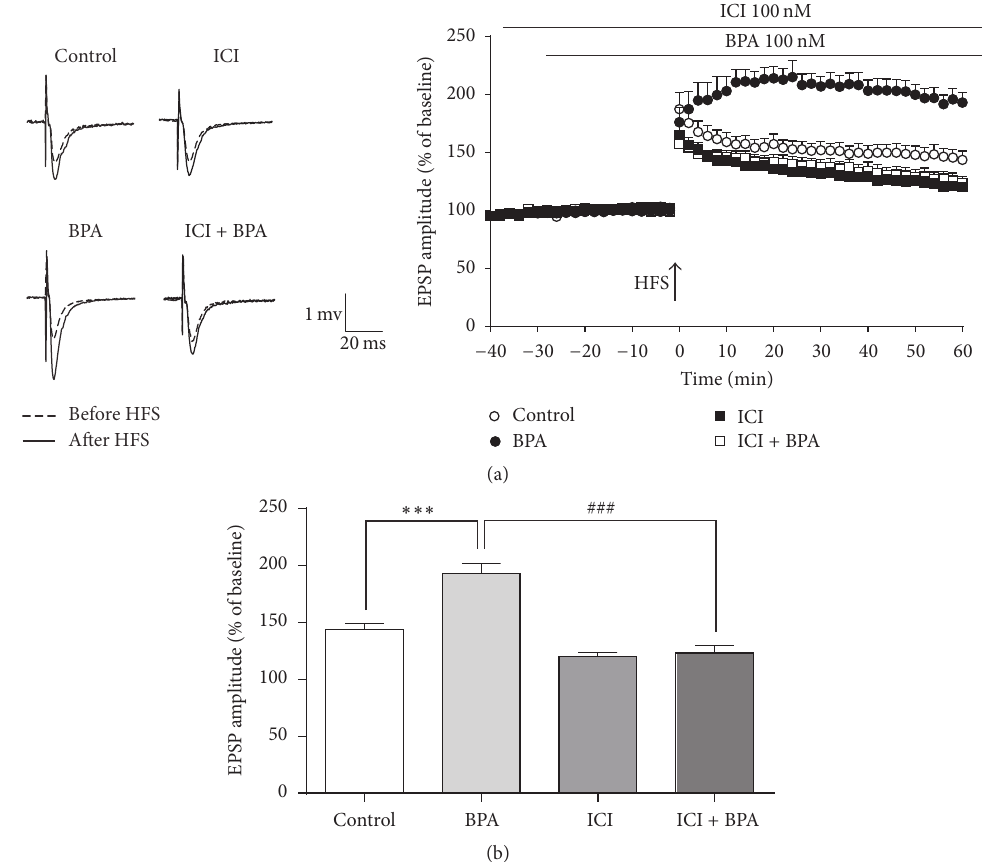
Figure 2: The enhancement of BPA on hippocampal LTP was ER-dependent. (a) Administration of ICI 182,780 10nM (an antagonist of ERs, filled square, 𝑛 = 8 ) remarkably decreased the 100 nMBPA-induced enhancement of LTP. Pretreatment with the ERs antagonist ICI 182,780 30 min before BPA 100 nM (open squares, 𝑛 = 8 ) application completely blocked BPA-enhanced LTP compared with BPA alone. (b) Figure columns express the average fEPSP amplitudes after HFS in separate perfusion or coperfusion of BPA 100 nM and ICI 182,780 100nM, ∗∗∗ 𝑝 < 0.001 as compared to the control, ### 𝑝 < 0.001 as compared to the BPA 100 nM. Solid and dashed example traces before HFS and after HFS,